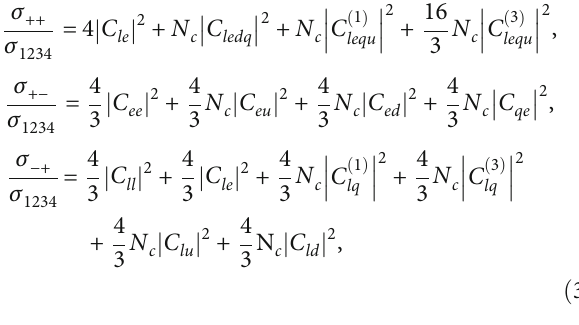
ffiffiffiffi p ffiffiffiffi p / . For instance, 0 : 447/1 : 095 = 0 : 4 , and so we see s s 1 2